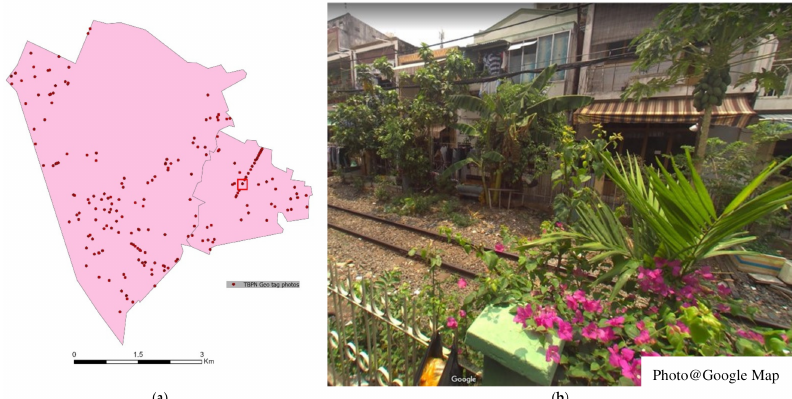
Figure 12. The railroad’s location in Phu Nhuan district ( a ) and its “railroad verge” area ( b ).